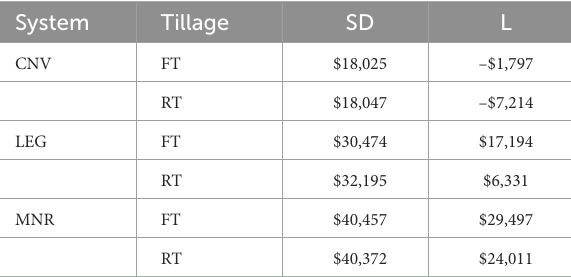
TABLE 4 Year-to-year variability (SD, standard deviation) and 75% lower confidence limits (L) for net returns in each tillage × system